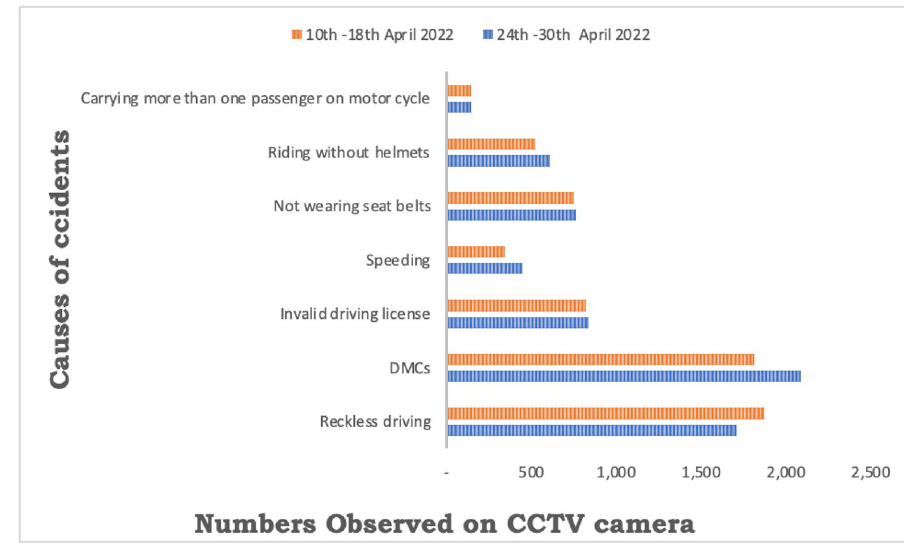
Fig. 2 Traffic offenders arrested and issued EPS tickets country- wide for various traffic offenses at various